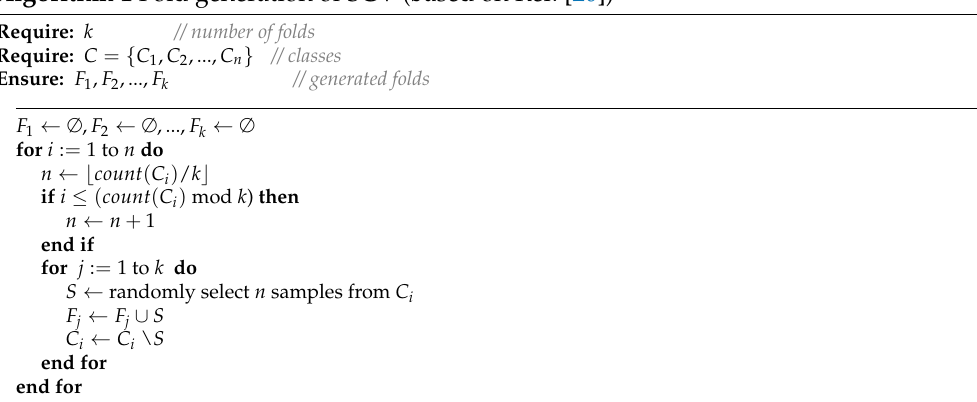
Algorithm 1 Fold generation of SCV (based on Ref. [20])